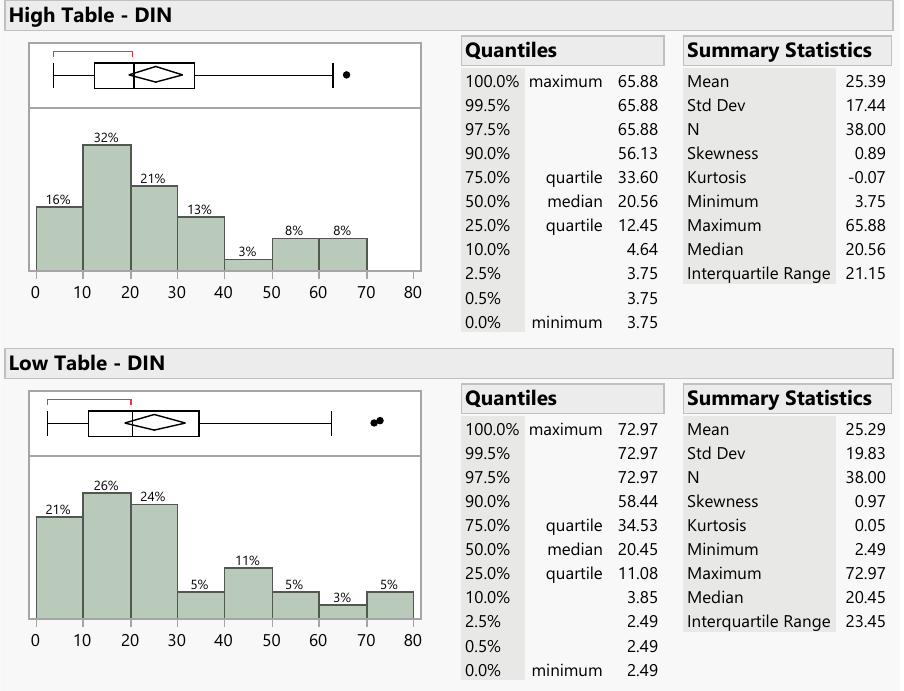
Figure 10. Distributions and statistics describing DIN data collected from the high table ( top panel) and low table ( bottom panel). Each panel includes a box-and-whisker plot ( top left corner) a histogram ( bottom left corner) and descriptive statistics ( right side) for paired samples collected using a high or low table in the top and bottom panels, respectively. The distributions are skewed but have similar means and medians. No outliers were removed. Data units are mg/m 2 .